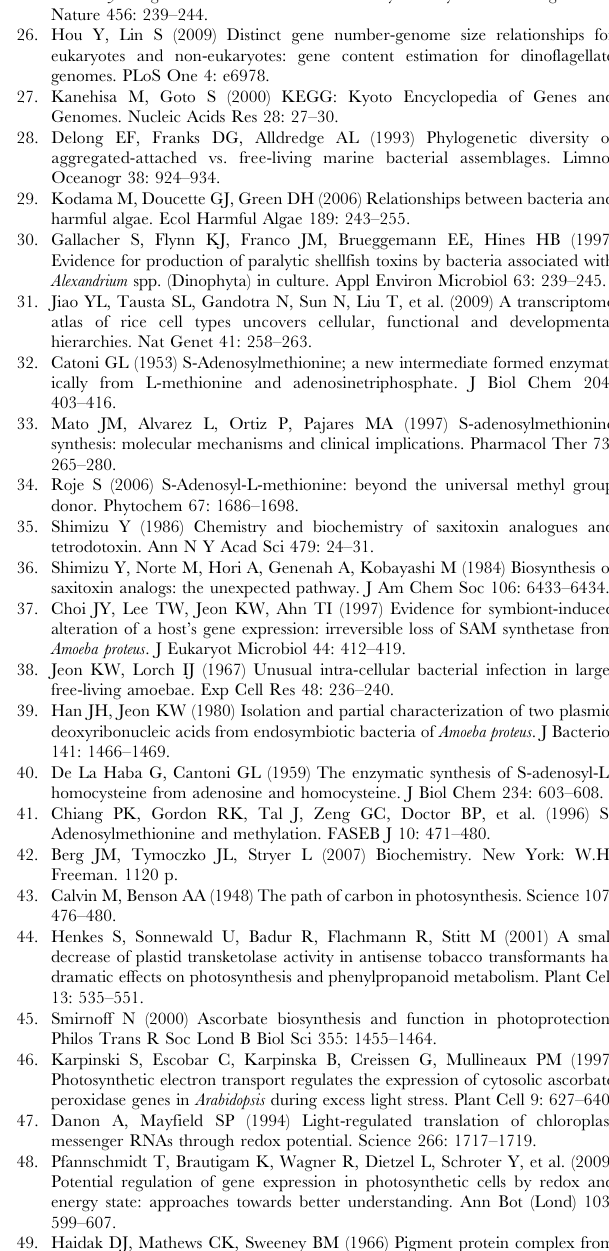
Figure S1 The set of unigenes derived from the dinoflagellate Alexandrium tamarense CCMP1598 using Sanger and 454